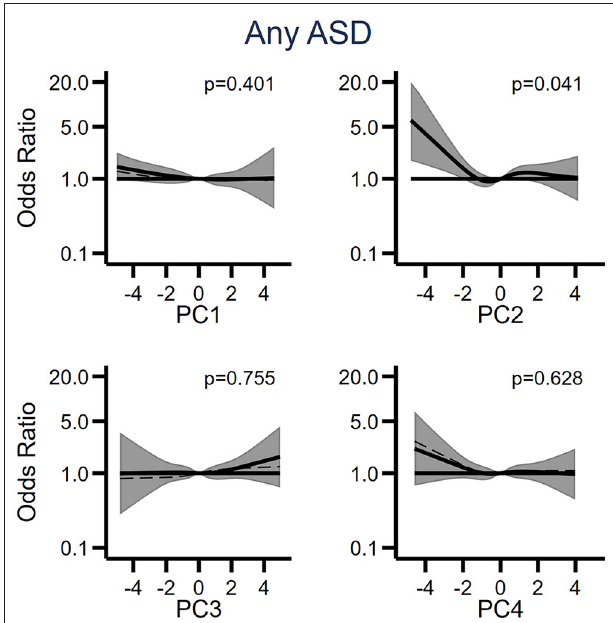
FIGURE 4 | The relationship between the first four principal components (PC1-PC4) derived from cytokines and acute phase proteins, and odds of ASD when comparing 318 individuals affected by ASD to 429 unaffected individuals selected from the cohort. Each panel displays the odds of ASD according to principal component scores, flexibly fit using restricted cubic spline models with four knots and a score 0 as the referent. The dashed line represents the = unadjusted estimate of the relationship between each principal component and odds of ASD. The solid line represents the fully adjusted model, adjusted for sex of fetus; family income quintile; maternal BMI, psychiatric history, region of origin, and age. The gray bands represent the 95% confidence interval for the fully adjusted model. P -values are shown for a Wald test with a null hypothesis that all spline terms were jointly equal to zero, as a test of whether each principal component was generally associated with the outcome. PC, principal